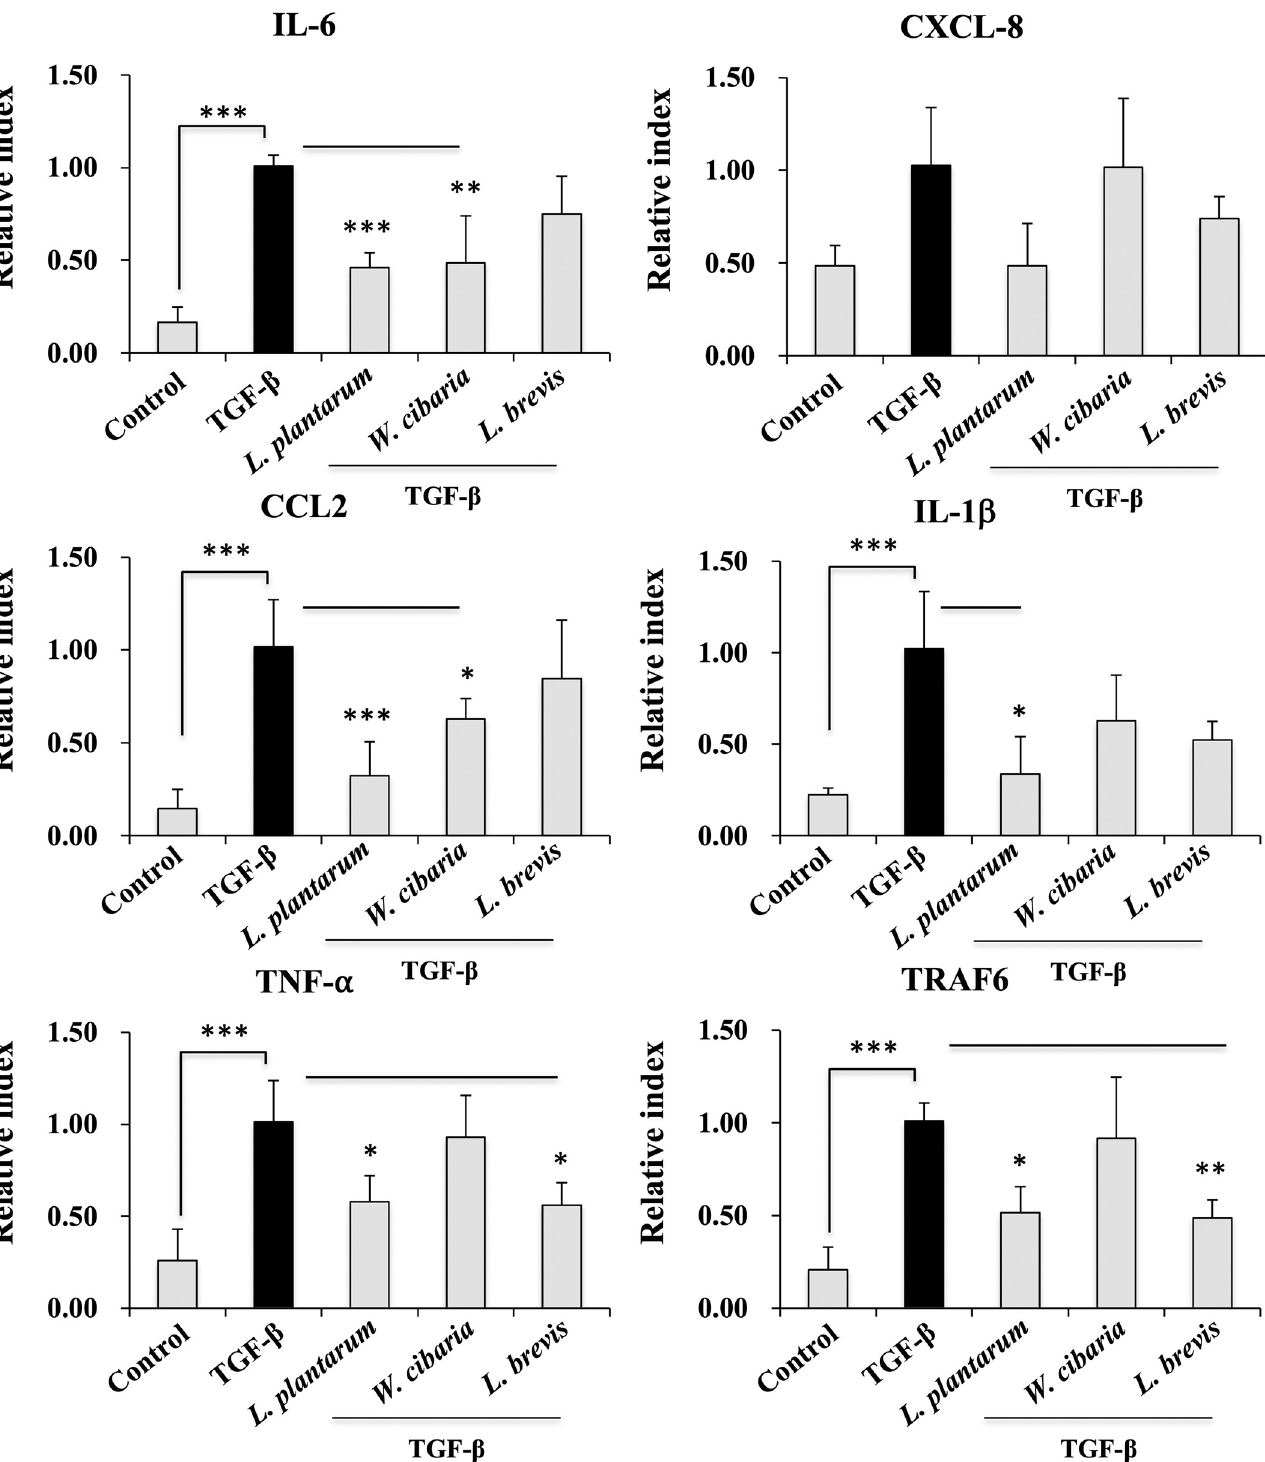
Fig 4. Effect of LAB on TGF- β induced proinflammatory cytokine/chemokine expression in LX-2 cells. Confluence LX-2 cells were treated with LAB for 48 h, and stimulated with TGF- β for 24 h. The IL-6, CXCL-8, CCL2, IL-1 β , TNF- α , and TRAF6 expression levels were determined by RT-PCR. The LX-2 cells, either with medium or TGF- β alone, were used as the negative and positive control. Two independent experiments (n = 3) were performed, and the average values (mean + S.D) are shown. � p < 0.05, �� p < 0.01, ��� p < 0.001.